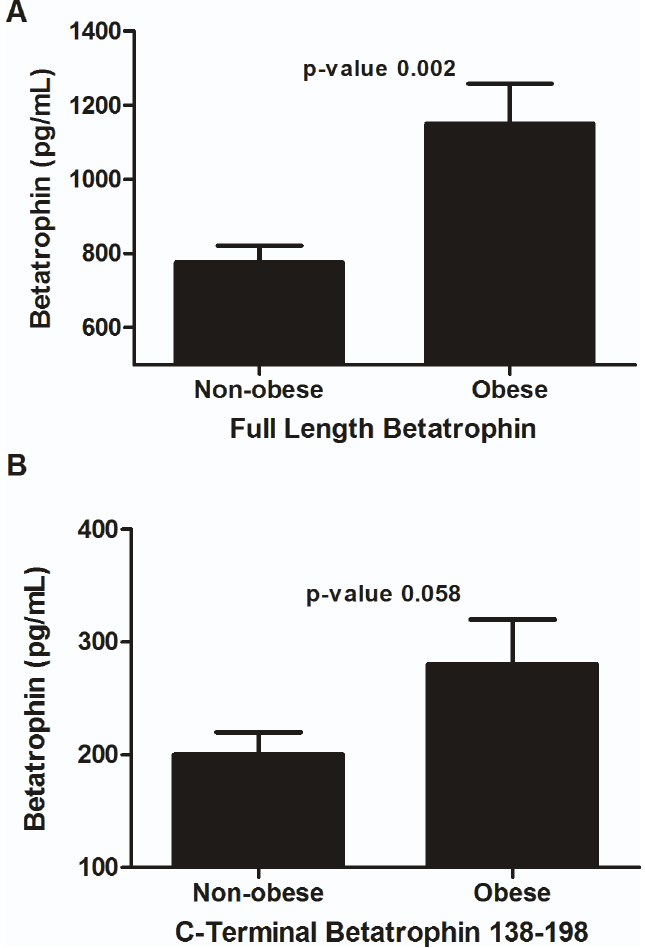
Fig 1. ANGPTL8 level obese vs. non-obese. A : Level of full length form of ANGPTL8 in non-obese vs. obese subjects in circulation. B : Level of C-terminal 139 – 198 form of ANGPTL8 in non-obese vs. obese subjects in